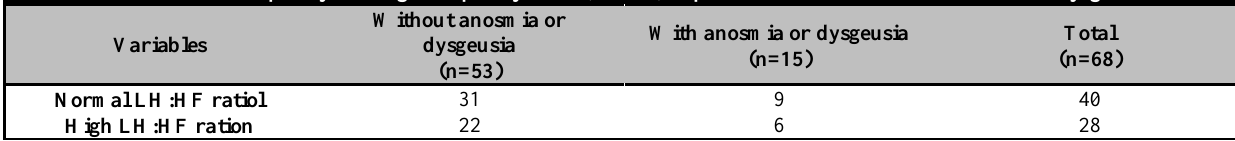
Table 1: Low-frequency and high-frequency ratio (LF:HF) in patients affected or not of anosmia or